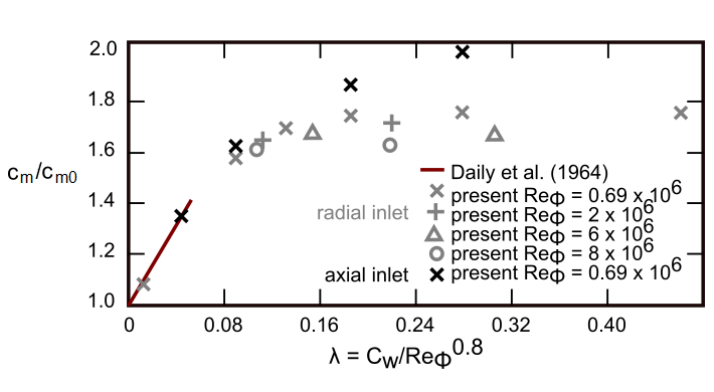
Figure 13. Effect of throughflow on moment coefficient [85].